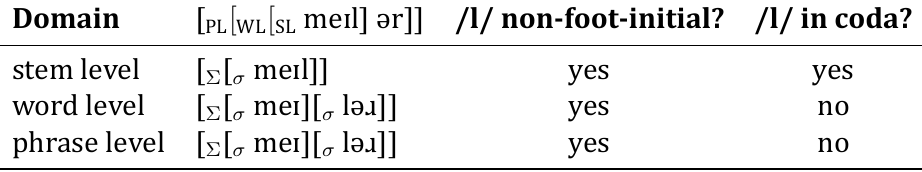
Table 7: Stratal-cyclic derivation of